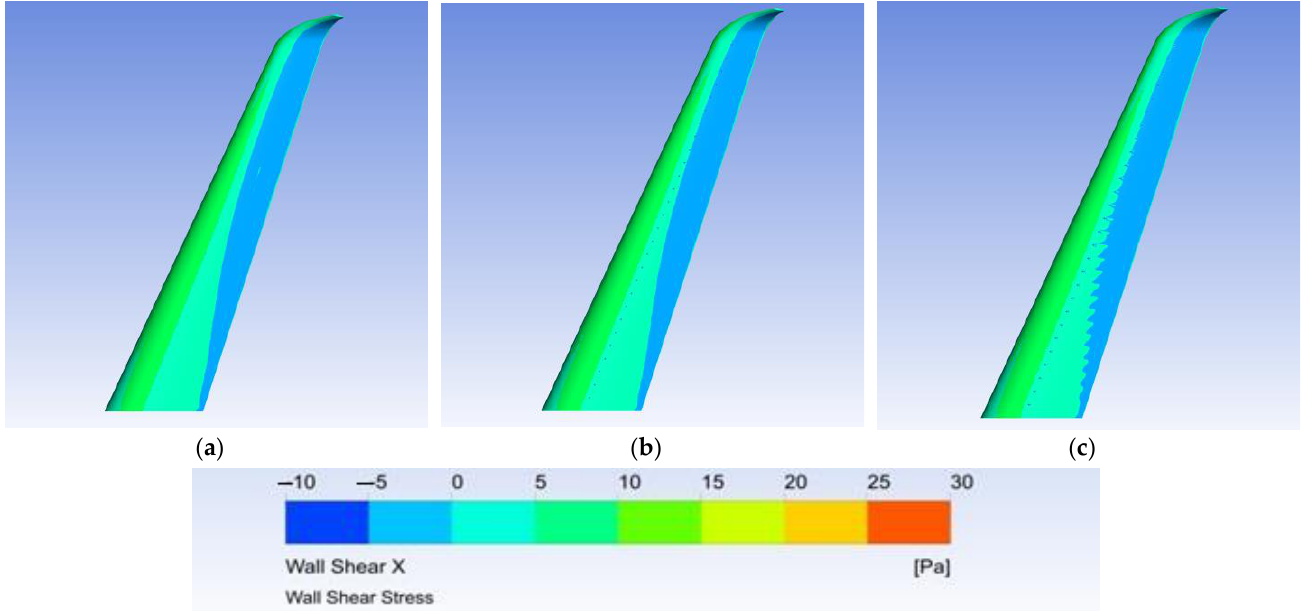
Figure 16. X-component of the wall shear stress at 8° AoA, and Re = 258,000, at the suction side of the ( a ) original wing, ( b ) wing with dimples, and ( c ) wing with bumps.